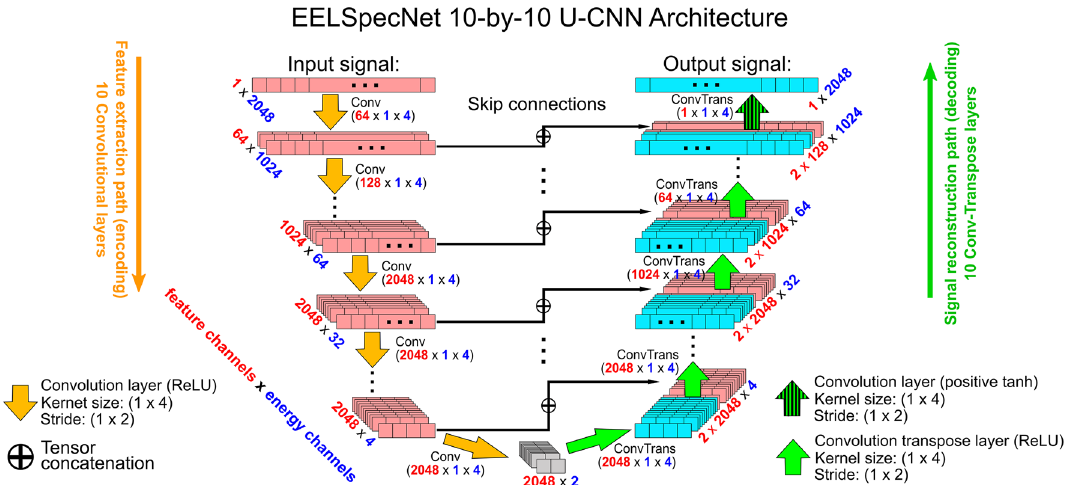
Figure 1. EELSpecNet 10-by-10 U-shaped fully convolutional neural network architecture with 10 layers for feature extraction (encoding) and 10 layers for signal reconstruction (decoding). As is demonstrated, input